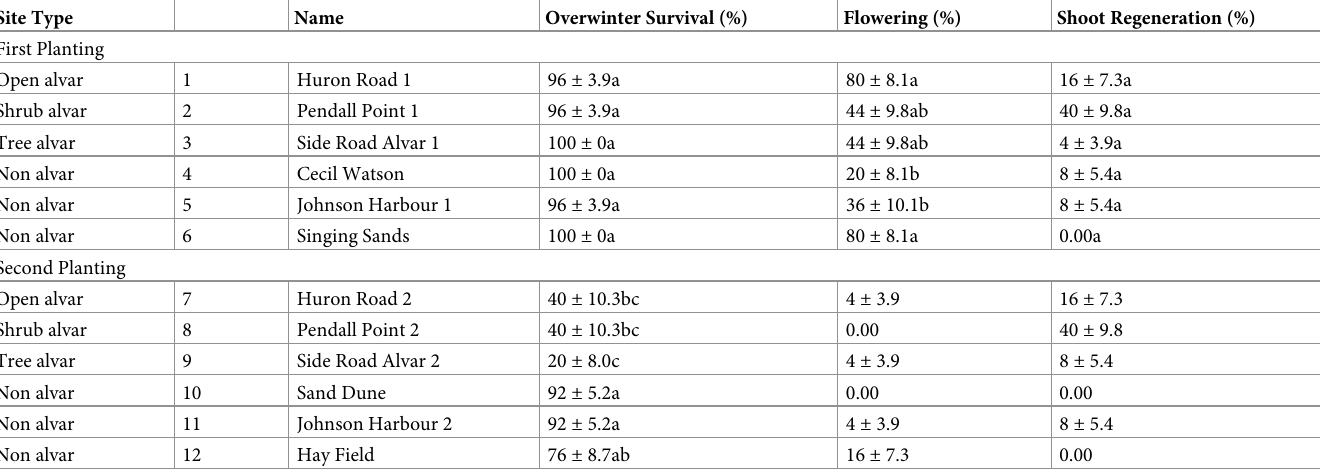
Table 3. The percentages of plants showing overwinter survival and shoot regeneration recorded in May 2018 and flowering in July 2018 of all micropropagated Hill’s thistle plants reintroduced to Bruce Peninsula National Park in Tobermory, Ontario. The first planting in June 2017 occurred on sites 1 to 6 and the second planting in July 2017 occurred on sites 7 to 12. Twenty-five plants were randomly assigned to plots within an area of 20 m 2 on each site. Data represents mean ± standard error from 25 plants per site. Means followed by different letters in columns are significantly different according to Tukey’s HSD test (P-value <